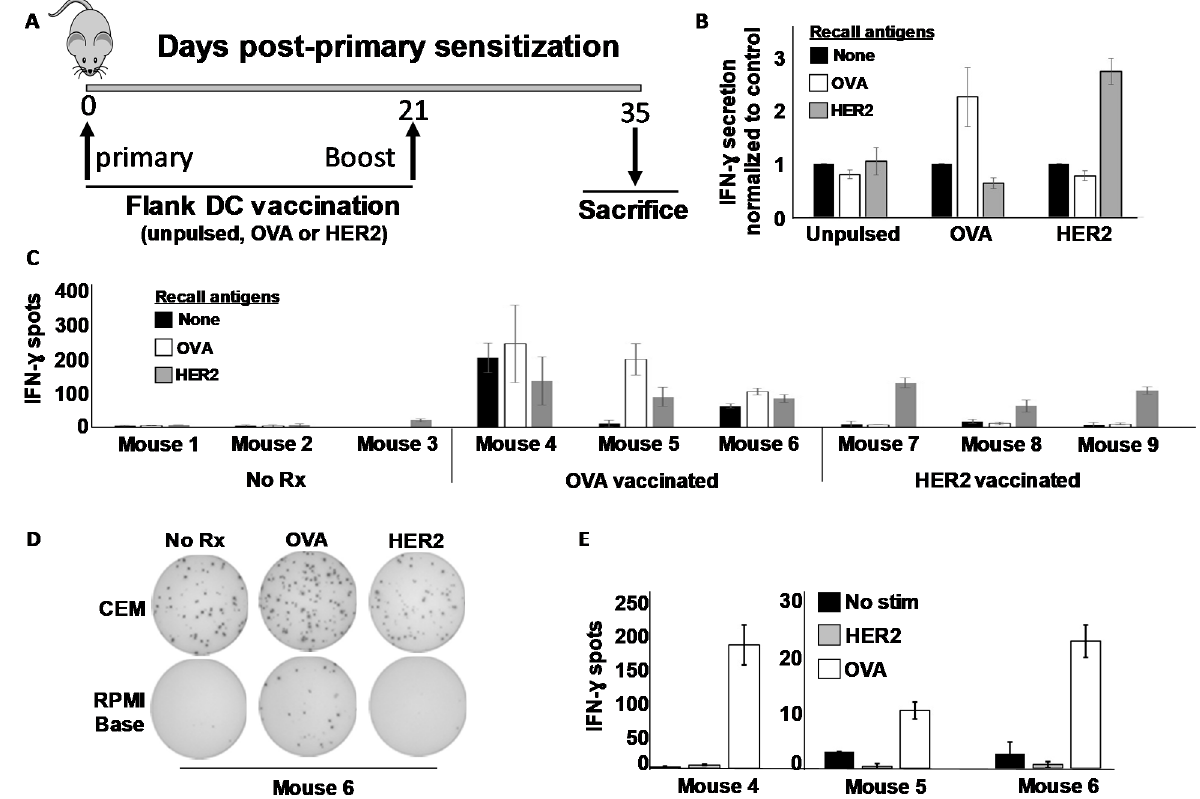
Figure 2. Murine DCs cultured in a serum-free medium can prime in vivo against both MHC class I and class II-restricted antigens. ( A ) Schema of sensitization protocol. Balb/c mice were vaccinated subcutaneously in the flank on day 0 with 1 × 10 6 SFM-DC loaded with either OVA (ISQAVHAAHAEINEAGR) MHC class II peptide, rat ErbB2/HER2 (TYVPANASL) MHC class I peptide or left unpulsed. Mice received an identical booster on day 21, and on day 35 mice were sacrificed and immune splenocytes subjected to analysis. ( B ) IFN- γ ELISA analysis of 24 h culture supernatants from immune splenocyte (three mice per treatment group) stimulated with various recall antigens. ( C ) IFN- γ ELISPOT analysis from stimulated splenocytes from individual mice. ( D ) Digital images of ELISPOT wells from representative mouse (#6) performed in either commercial ELISPOT culture medium (CEM; upper images) or base RPMI medium (lower images). ( E ) Enumeration of IFN- γ spots from splenocytes of vaccinated mice stimulated in base RPMI medium without added serum. Error bars for all panels indicate SEM.